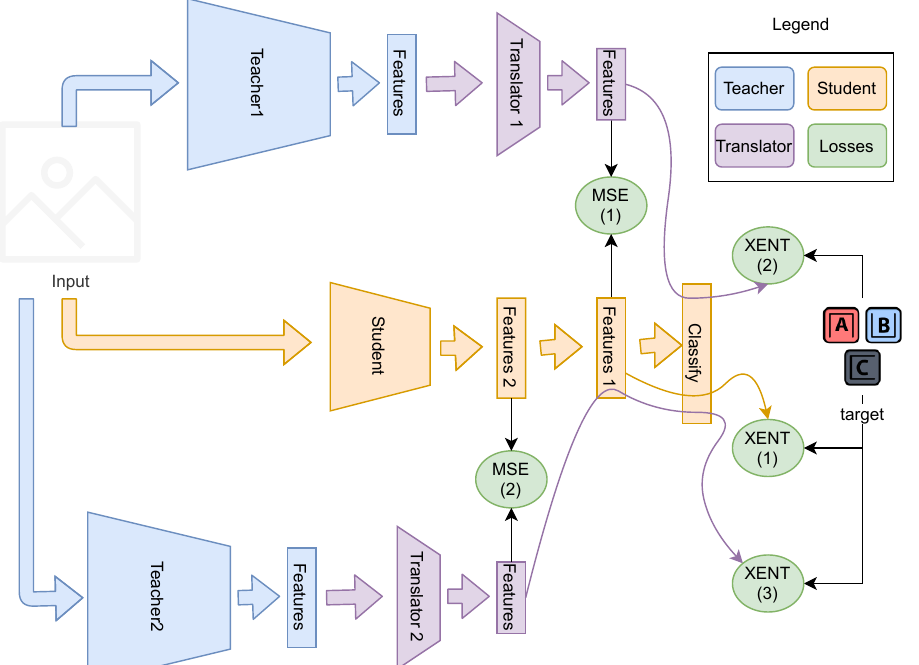
Figure 3. Proposed approach with two teachers. We can distinguish four different networks: the teacher, the translator 1, the translator 2, and the student. The loss functions MSE(1), XENT(1), and XENT(2) are composed as in Figure 2, however, here we also add MSE(2) between the features of Translator2 and the student’s layer Features2 and the third cross-entropy XENT(3) using the features of Translator2 and the student’s classification